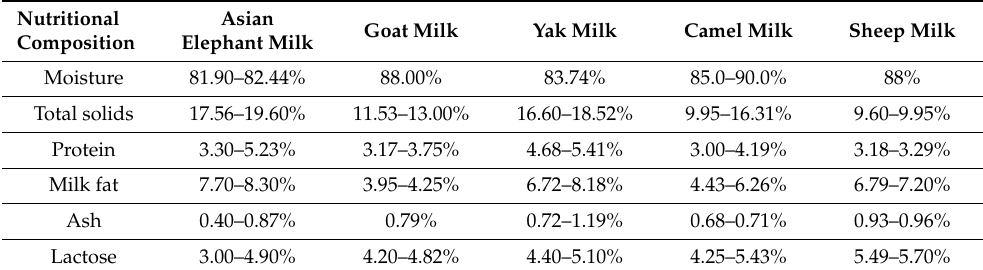
Table 1. Comparison of the nutrient composition and content of various kinds of